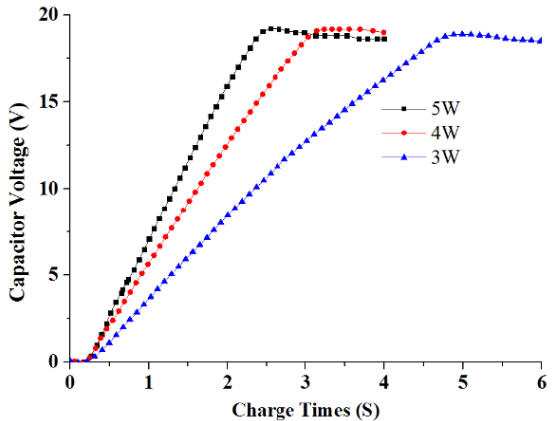
Figure 13. Curve of capacitor voltage and charging time.